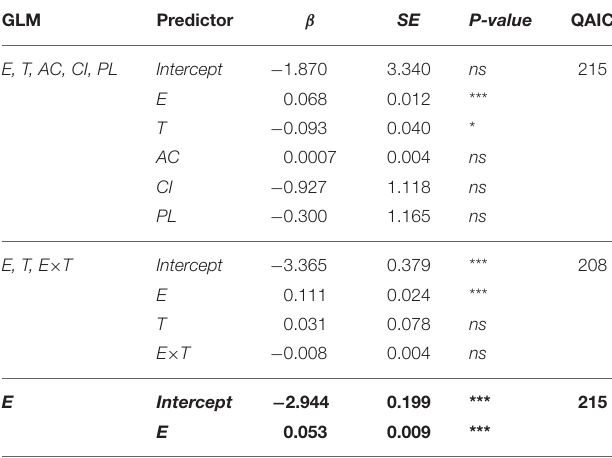
TABLE 2 | Results from the generalized linear models (GLM) fitted to predict the number of C. hyperboreus eggs ingested by female M.